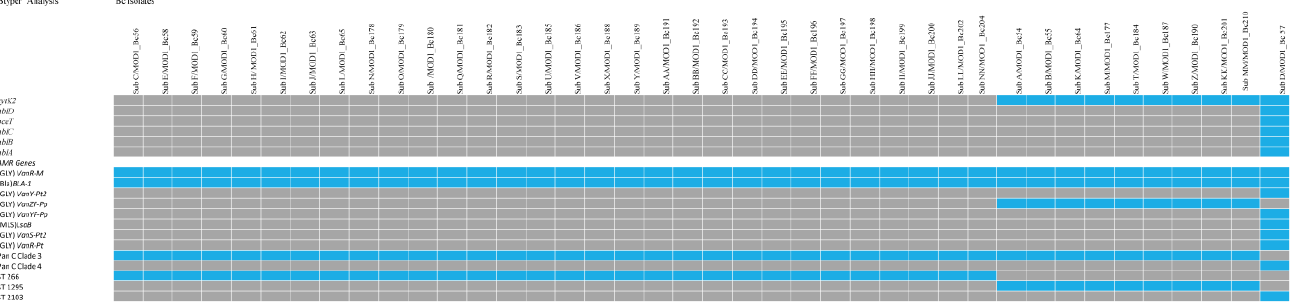
Figure 2. The heatmap represents the presence/absence of B. cereus virulence, antimicrobial resistance genes (AMR ), panC phylogenic typing genes, and ST designations identified in baby wipe strains using BTyper. All the baby wipes strains possessed nheBAC , entAFM , bpsEFH , cerAB , clo , plcABR , and inhA1A2 . ST1295 strains possessed the additional virulence factor, cytK2 . The lone ST2103 strain carried cytK2 , hblDAC , bceT, and hblB as additional virulence factors. There were seven AMR genes which included (GLY) VanY-Pt2 , (GLY) VanYF-Pp , (MLS) LsaB , (GLY) VanS-Pt2, and (GLY) VanR-Pt , along with (GLY) VanR-M and (Bla) BLA-1 found in all the strains. All strains except for Bc57 ST2103 were identified as panC -positive. Bc57 ST2013 was identified as a panD -positive strain. The presence of the gene is indicated in blue, and the absence is indicated in gray. The measured parameters were consistent with the ST of the strains.